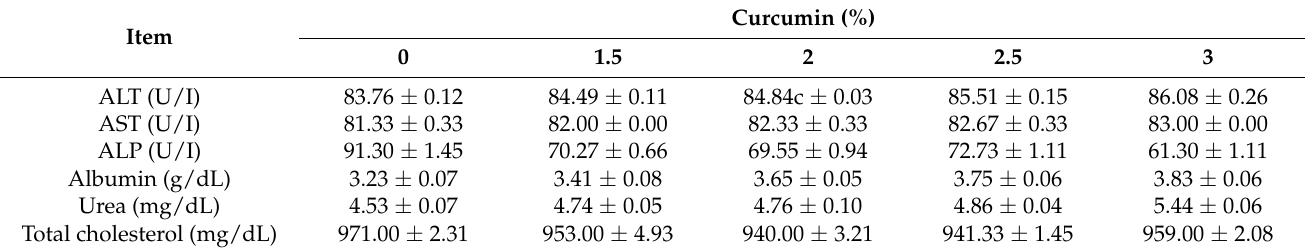
Table 5. Blood biochemical indices of Gilthead seabream fed varying levels of dietary curcumin for 150